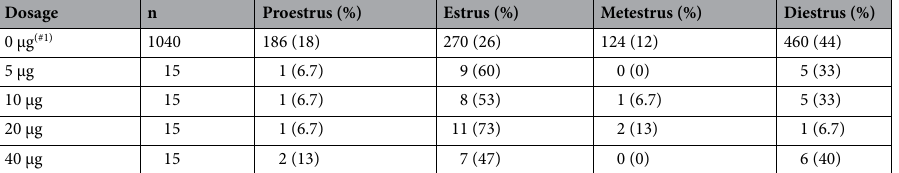
Table 1. Estrus stages at Day 4 after LHRHa administration in ICR females. (#1) Vaginal smear samples were collected from randomly chosen female